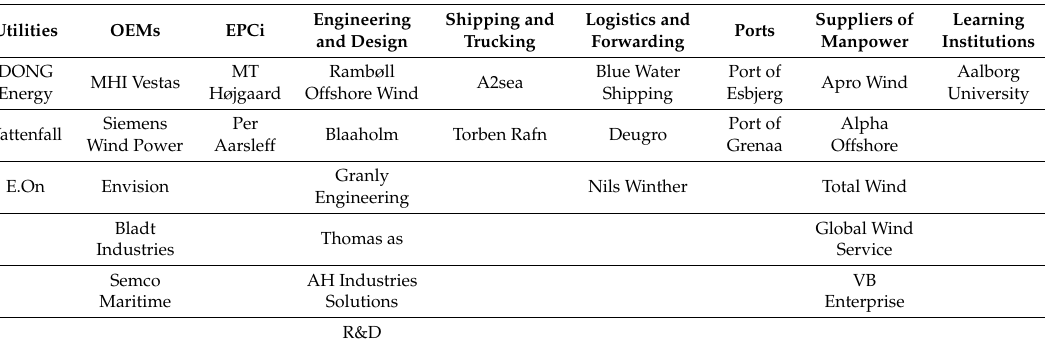
Table 3. Main Cost Reduction Forum member